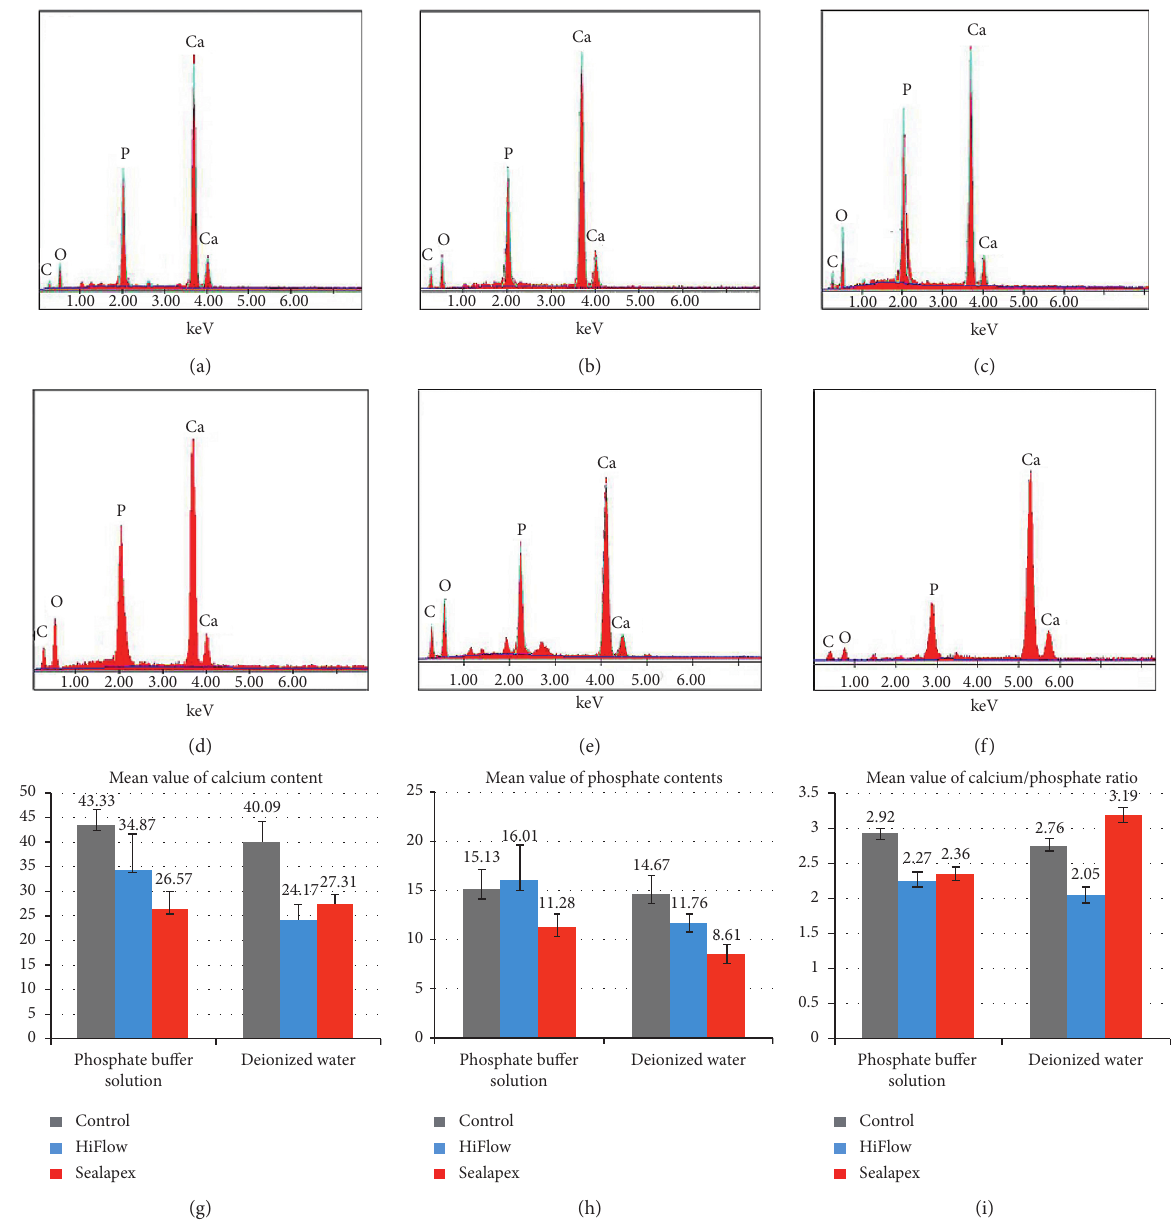
Figure 3: The EDX analysis of untreated dentin (a-b) and dentin treated with HiFlow (c-d) and Sealapex (e-f) stored in either PBS or deionized water for 60 days. There were changes in means of calcium (g) and phosphate (h) constituents (weight%) as well as calcium/ phosphate ratio (i) of radicular dentin treated with root sealers compared with control untreated dentin stored in either phosphate buffer solution or deionized water for 60